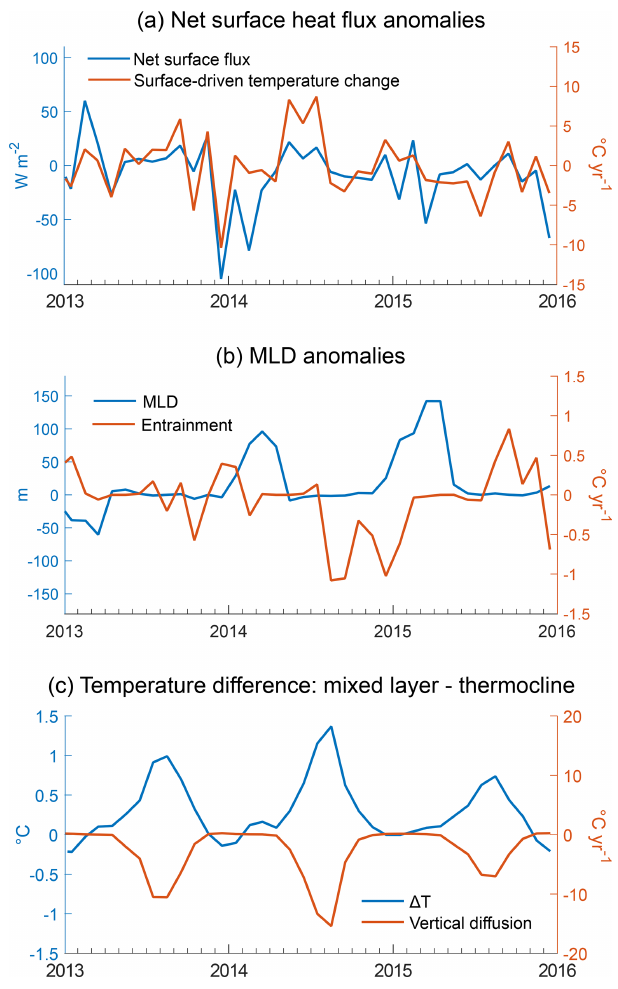
Figure B5. Time series of the individual components that comprise the dominant temperature budget terms and the associated change in mixed-layer temperature, both averaged over the cold blob region in ECCOv4-r3. (a) Anomalies in the heat flux into the surface output by the model, defined as Q net in Eq. (1) (Wm − 2 ; blue), and anomalies in the associated change in mixed-layer temperature, i.e. the surface flux term of the mixed-layer budget ( ◦ Cyr − 1 ; red). (b) Anomalies in MLD (m; blue) and the associated entrainment term of the mixed-layer budget ( ◦ Cyr − 1 ; red). (c) The temperature difference between the mixed layer and the model cell immediately beneath ( ◦ C; blue), defined as (cid:49)T in Eq. (1), where positive values signify that the mixed layer is warmer than the thermocline, and the associated vertical diffusion term of the mixed-layer budget ( ◦ Cyr − 1 ; red). Note that the seasonal cycle has not been removed from either term in (c) .